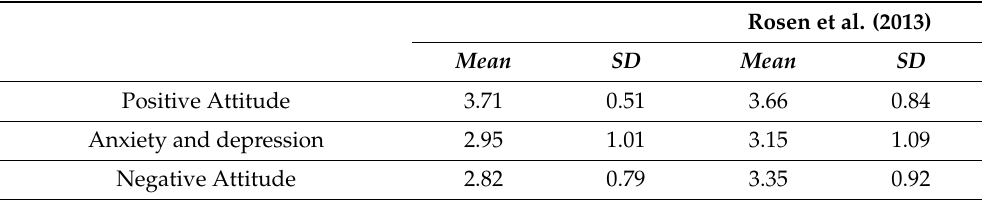
Table 6. Attitudinal profile toward ICT. Source: Authors’ creation.